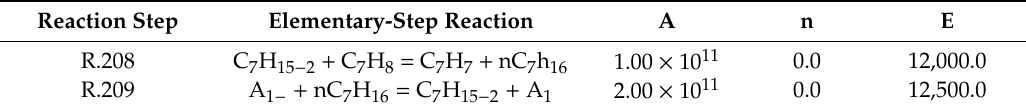
Table 1. Rate constant expressions and interactive reactions between n -heptane and toluene. Reaction Step Elementary-Step Reaction